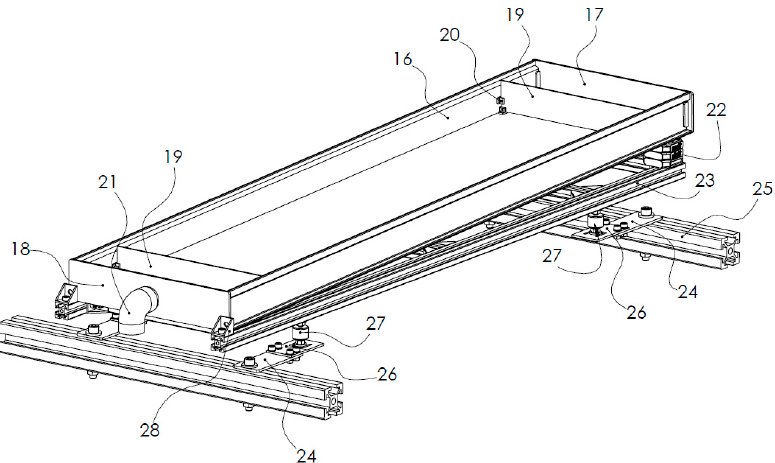
Figure 3. Growth tray unit: 16—growth tray, 17—growth tray’s back cover, 18—growth tray’s front cover, 19—a barrier preventing the washing out of grains, 20—grain barrier holders, 21—outlet, 22—plastic-calibrated 10 mm spacers, 23—aluminum profile, 24—bracket for mounting the load cell to the bench frame, 25—part of the bench structure, 26—load cells, 27—holders, 28—growth tray limiter to prevent sliding.